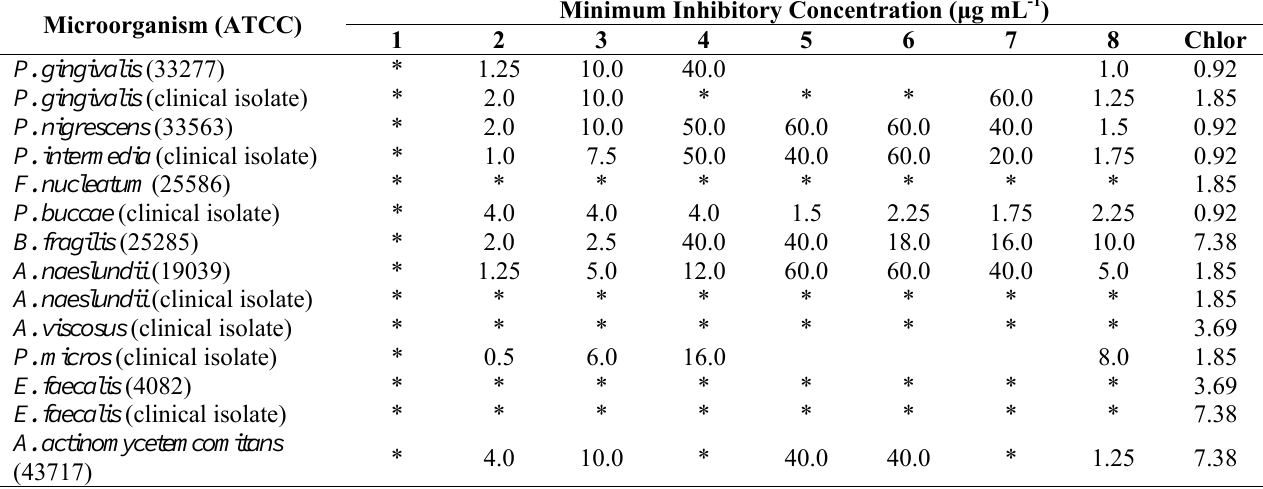
Table 1. In vitro antibacterial activity (MIC) of the pimarane-type diterpenes against endodontic